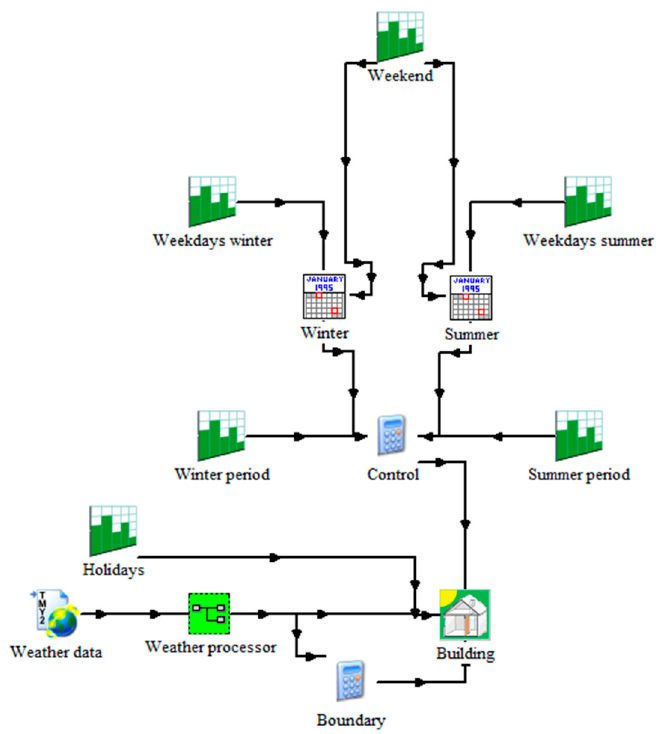
Figure 3. TRNSYS scheme for simulation of the building model.